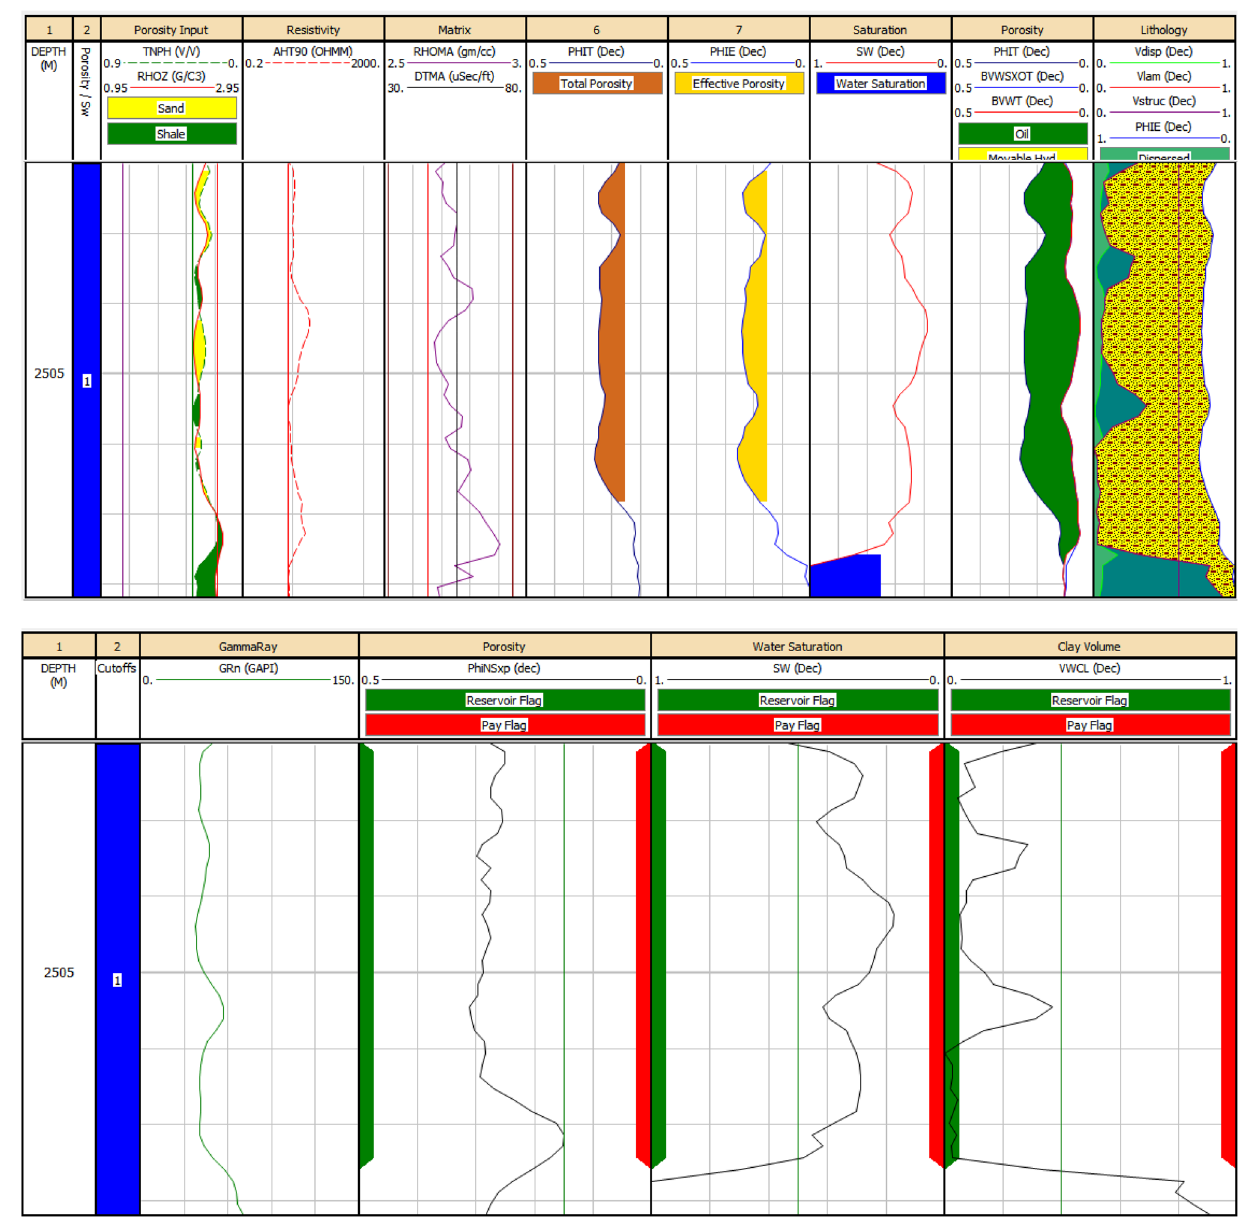
Fig. 9 Petrophysical and Pay zone summary graphical representation of X